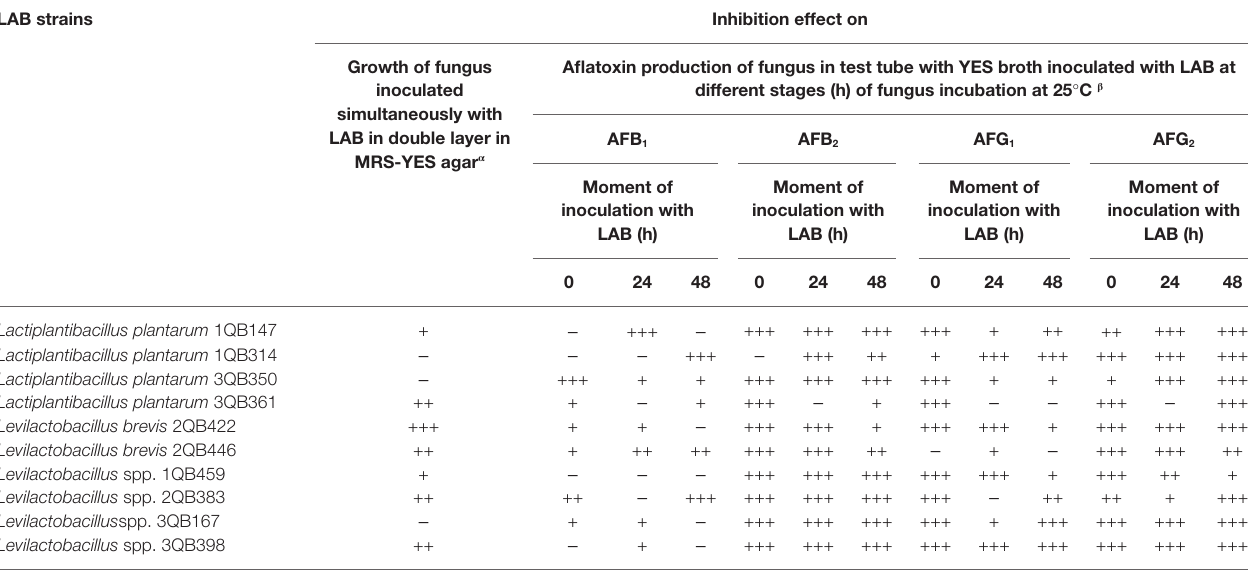
TABLE 4 | Overview of effect of LAB on inhibition of mycotoxigenic A. parasiticus NRRL 2999 growth and aflatoxins (AF) production (AFB 1 , AFB 2 , AFG 1 , and AFG 2 ), investigated in double layer agar plates with MRS and YES agars and in YES broth, respectively. LAB